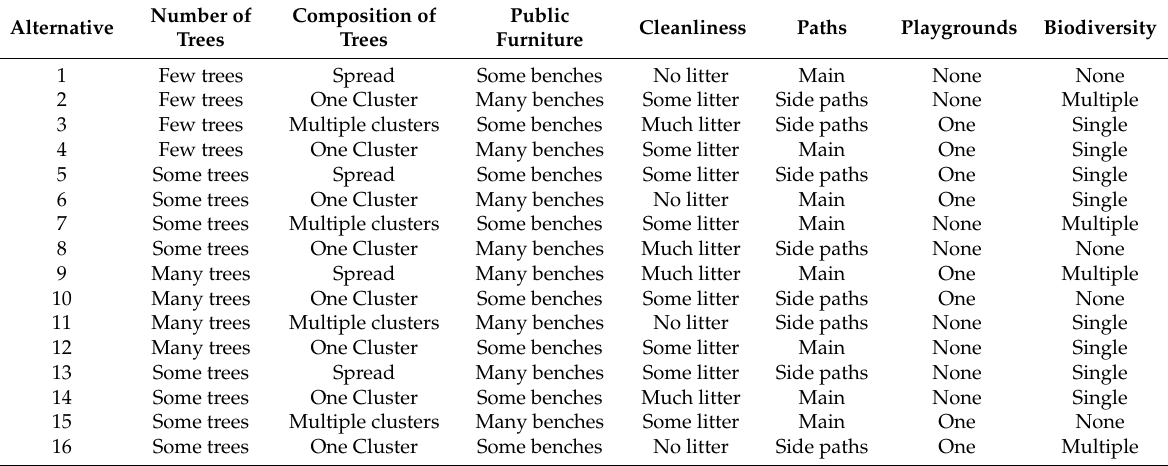
Table 1. Sixteen alternative park designs and their corresponding attribute